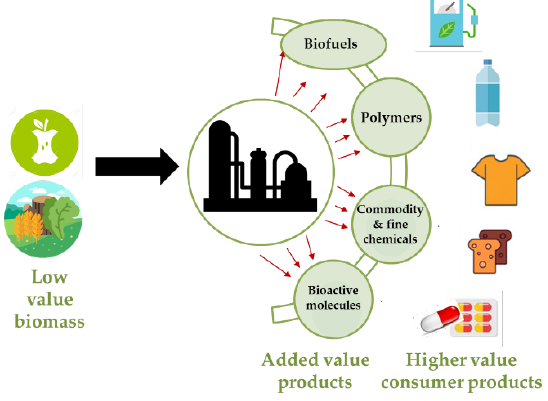
Figure 1. Schematic representation of the diversified set of products that can be produced in a biorefinery, including biofuels, polymers and commodity chemicals.